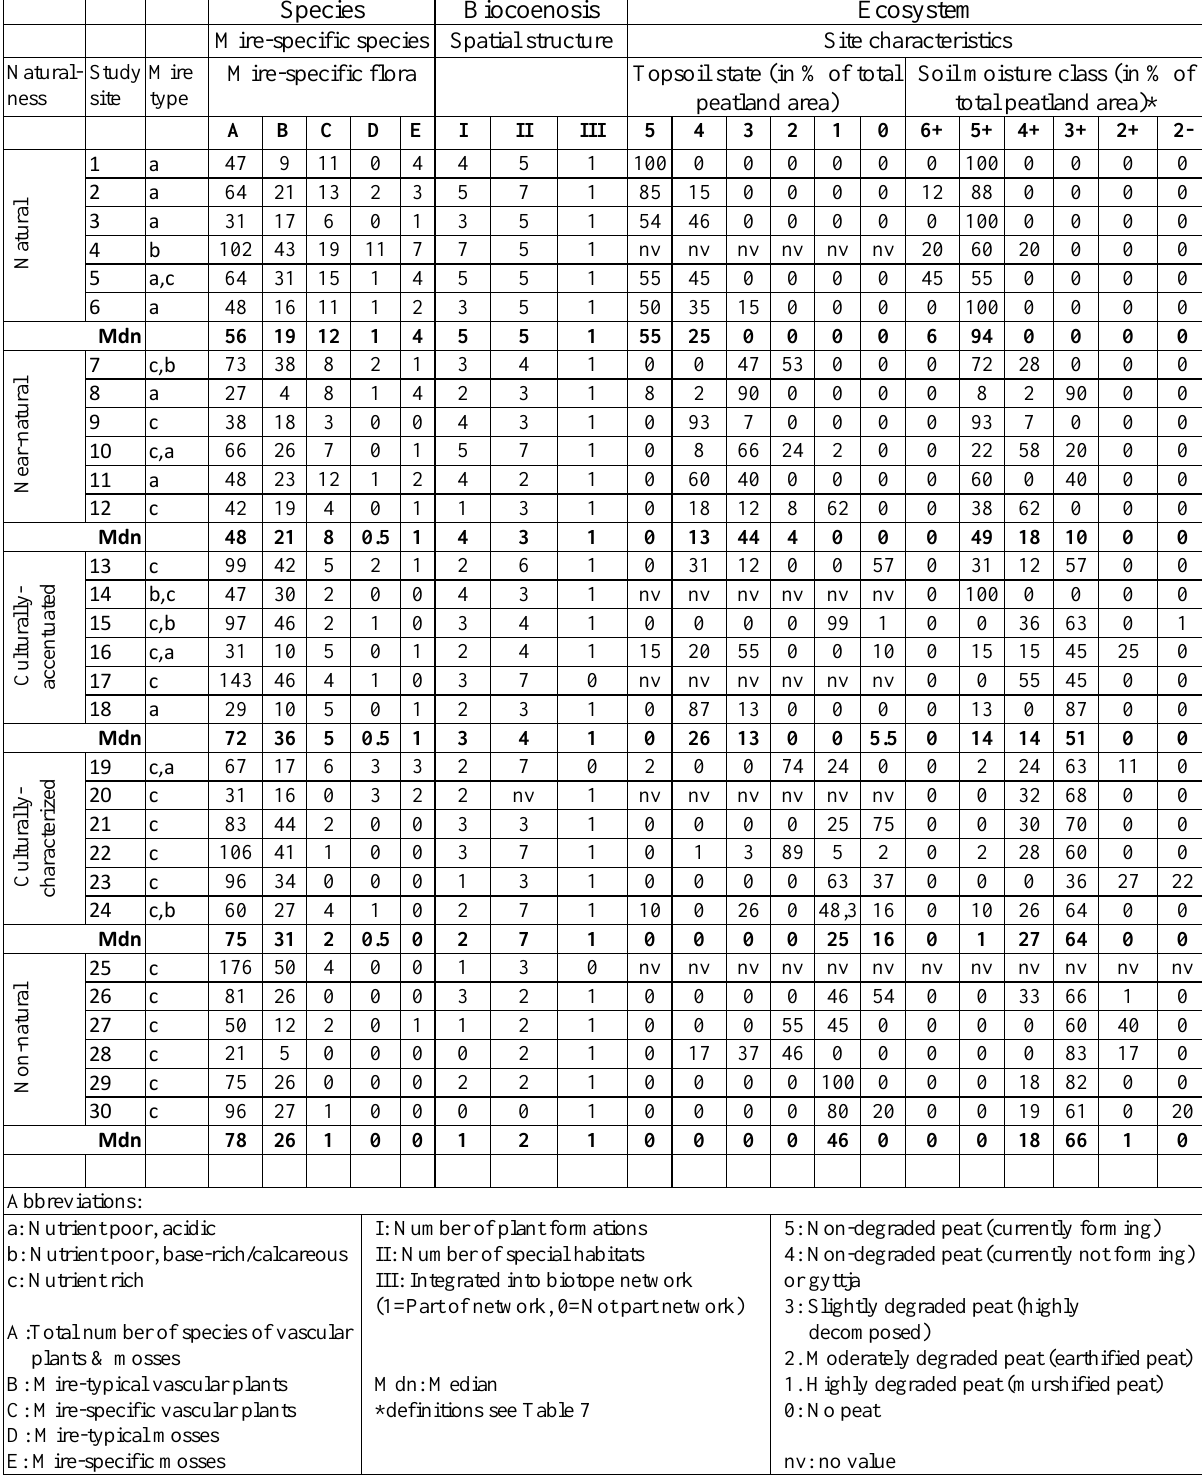
Table 7. Mire type, mire-specific flora (total number and number of mire-typical and mire-specific vascular plants and mosses), spatial structure (number of mire-typical plant formations and special habitats, integration into biotope network), topsoil state (no peat to non-degraded peat in % of total area) and soil moisture class (2- to 6+ in % of total area) for the 30 sampled peatlands in Brandenburg (north-east Germany), classified according to stages of naturalness (Wagner & Wagner